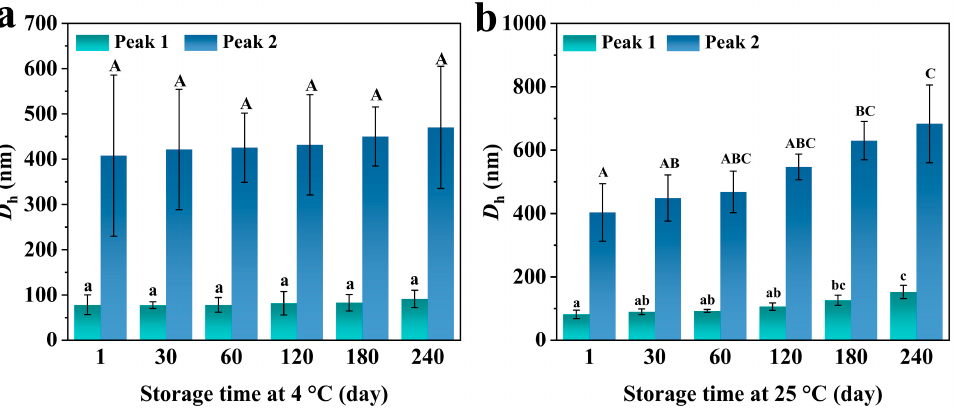
Figure 6. Variation in D h of CUR-SeNPs-H with storage time at ( a ) 4 ◦ C and ( b ) 25 ◦ C (different lowercase letters marked on the D h of P1 indicate significant differences, p < 0.05; different capital letters marked on the D h of P1 indicate significant differences, p < 0.05).